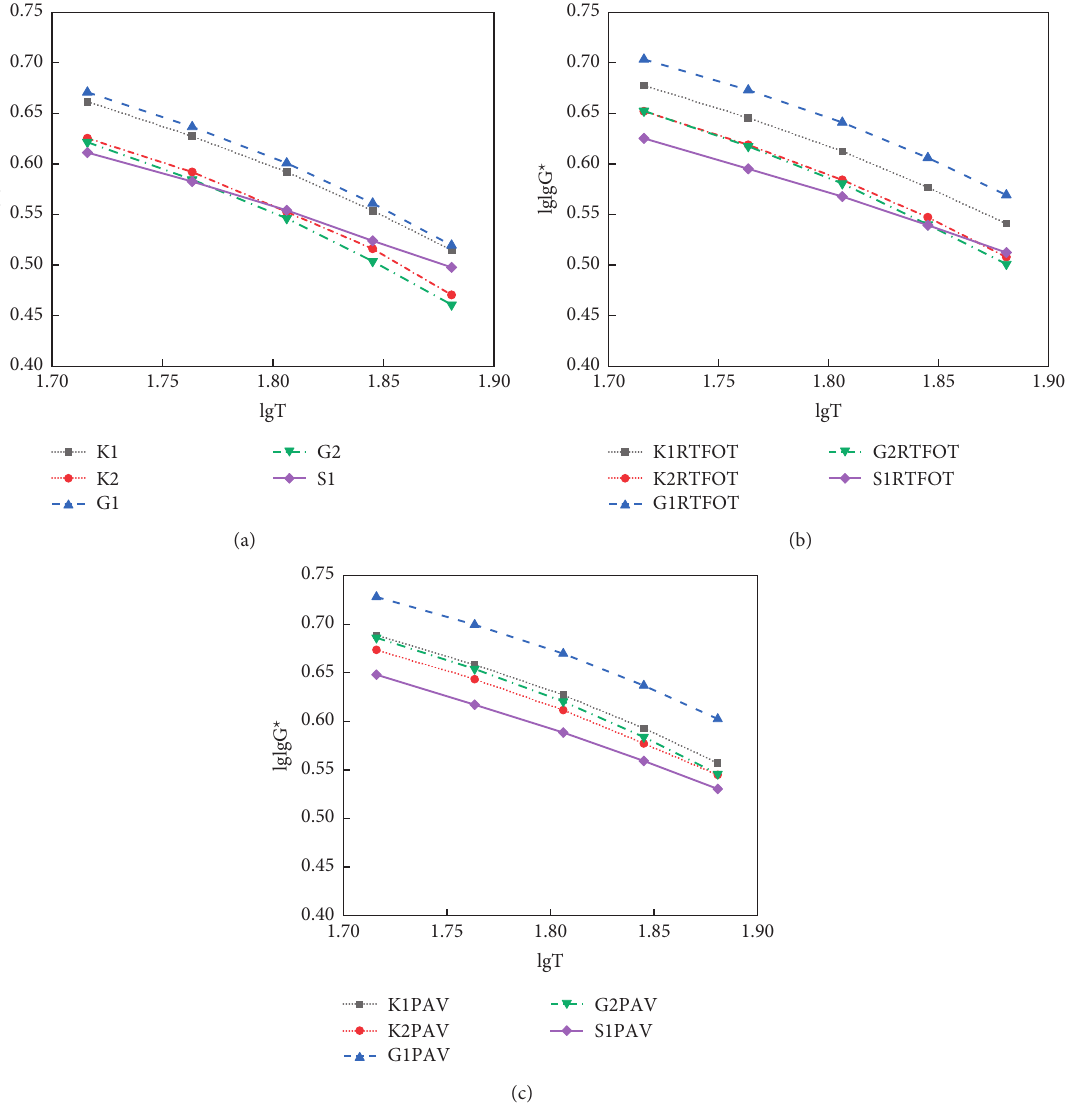
Figure 5: The relationship between the double logarithm of G ∗ and temperature. (a) Original asphalt. (b) Short-time aged asphalt. (c) Long- time aged